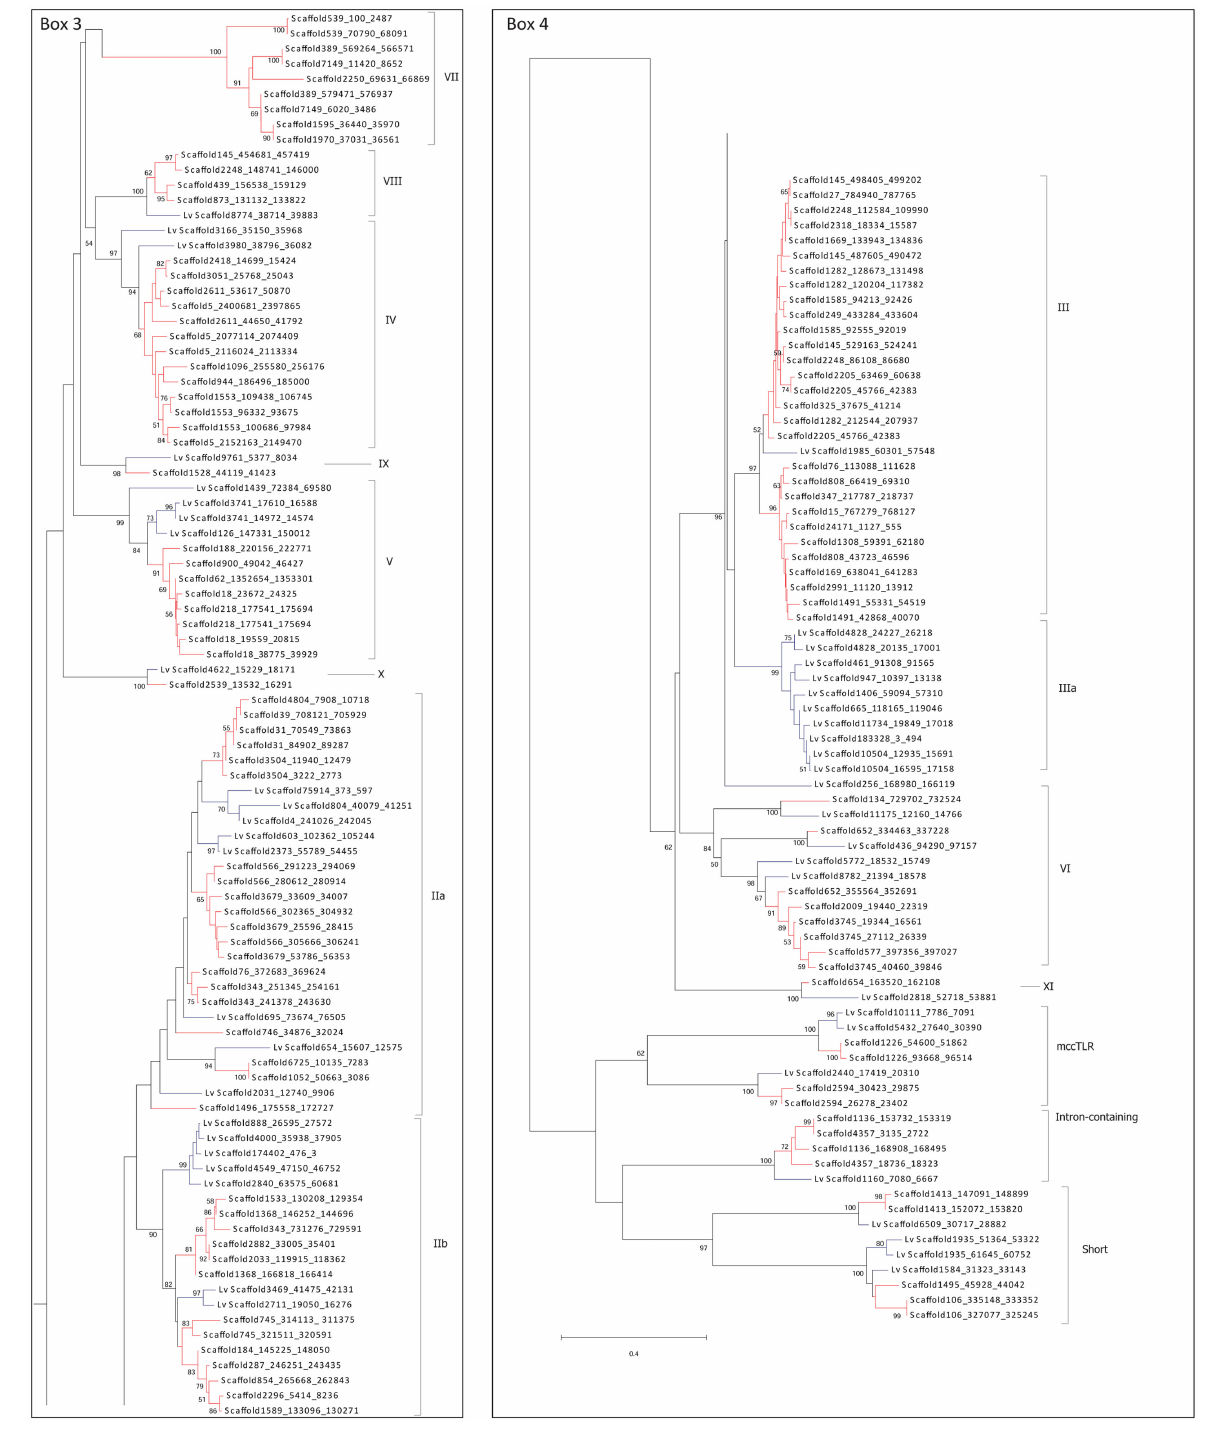
FIGUREA1 | Complete phylogeny of the sea urchinTLR sequences. The TIR domains of theTLR sequences from S. purpuratus and L. variegatus were used to construct the tree shown, which is a more detailed version of the tree in Figure 2 . Bootstrap values greater than 50 are shown. Red indicates clades that are specific to S. purpuratus , blue clades contain only sequences from L. variegatus , and black clades contain sequences from both species. Each of